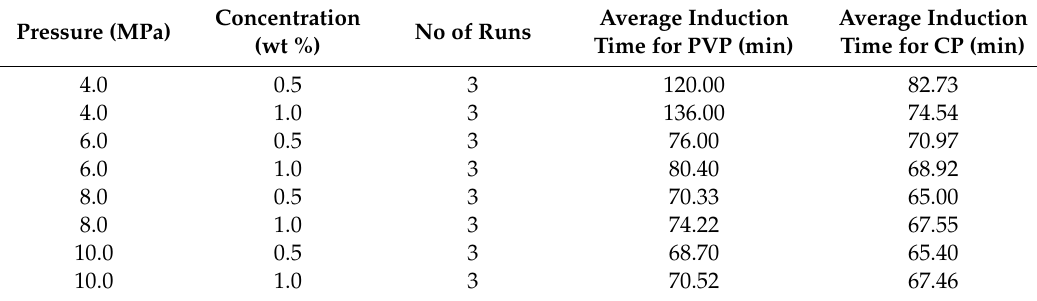
Table 4. Methane hydrate induction time in presence of PVP and CP as